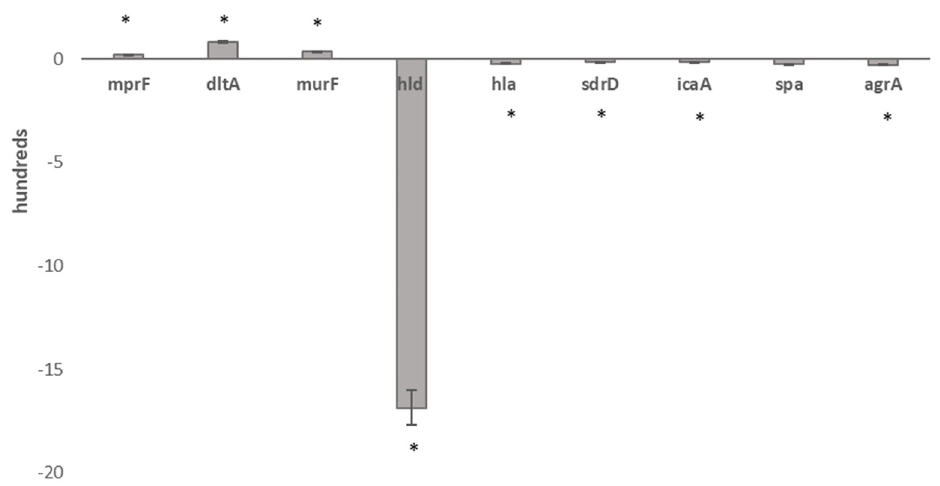
Figure 2. Real-time qPCR validation of RNA-seq data in 1-R vs. 1-S. Legend: * Statistically significant differentially expressed genes.